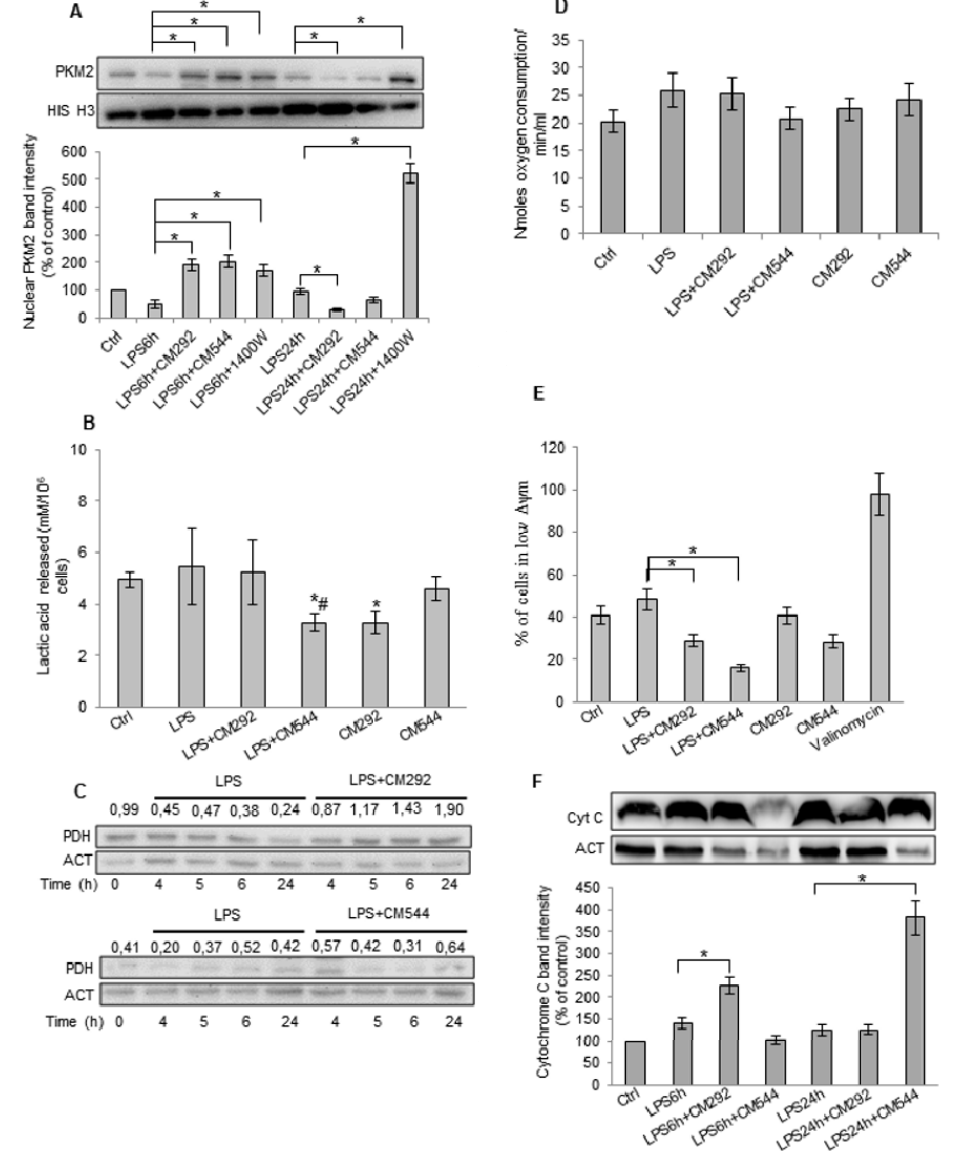
Figure 5. CM292 and CM544 reverted the effects of LPS on the metabolic profile of BV2 microglial cells. BV2 microglial cells were pre-treated with 10 μ g/mL LPS for 3h, and then 200 μ M CM292 or CM544 and 10 μ M 1400W were added for further for 3h or 21h. ( A ) Western blotting analysis of nuclear PKM2 at indicated time. Histone H3 was used as loading control. Bars represent the ratio between respective protein and histone H3 band intensity. The images are representative of one out of three separate experiments; ( B ) lactic acid released after 24h exposure. Data represent mean ± SD of n = 3 independent experiments performed in triplicate. * p < 0.05 vs. control cells. # p < 0.05 vs. LPS treated cells; ( C ) Time course of pyruvate dehydrogenase (PDH). At each indicated time, cells were collected, and total extract analyzed by Western blotting. β -actin was used as loading control. Numbers above the images represent the ratio between respective protein and β -actin band intensity. The images are representative of one out of three separate experiments. ( D ) Oxygen consumption after 24 exposure. Data represent mean ± SD of n = 3 independent experiments performed in duplicate. * p < 0.05 vs. control cells. # p < 0.05 vs. LPS treated cells; ( E ) Δψ m after 24h exposure. Bars represent the percentage of cells with low Δψ m. ( F ) Western blotting analysis of total cytochrome C. Actin was used as loading control. The images are representative of one out of three separate experiments.